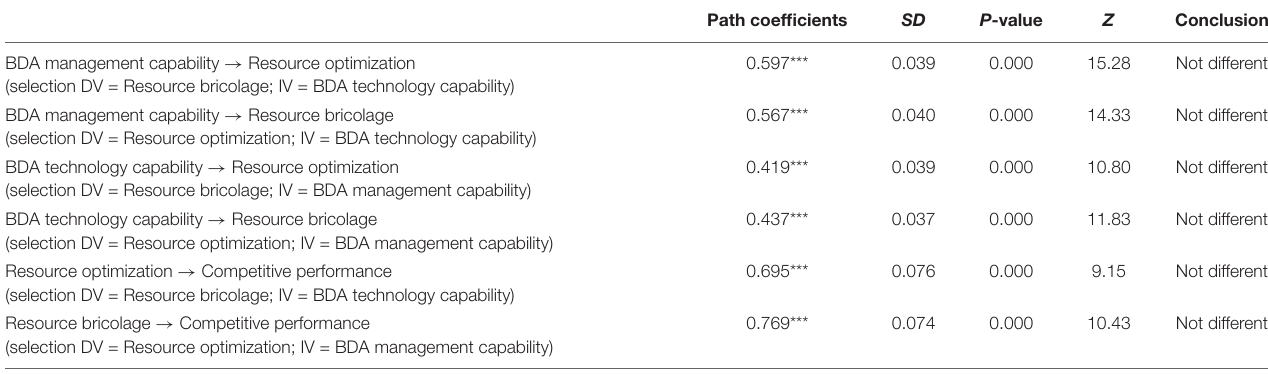
TABLE 6 | Endogeneity test ( N = 219).